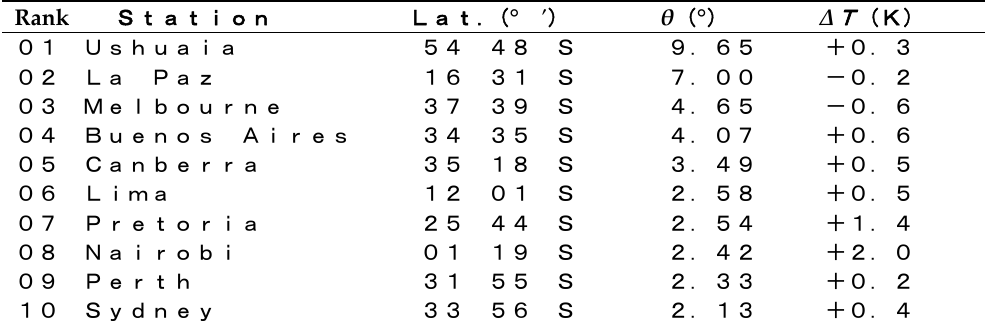
Table 4. Southern Hemispheric stations in the rotation angle of the monthly distributions of temperatures from Period II (1951 ‐ 1980) to III (1981 ‐ 2010).